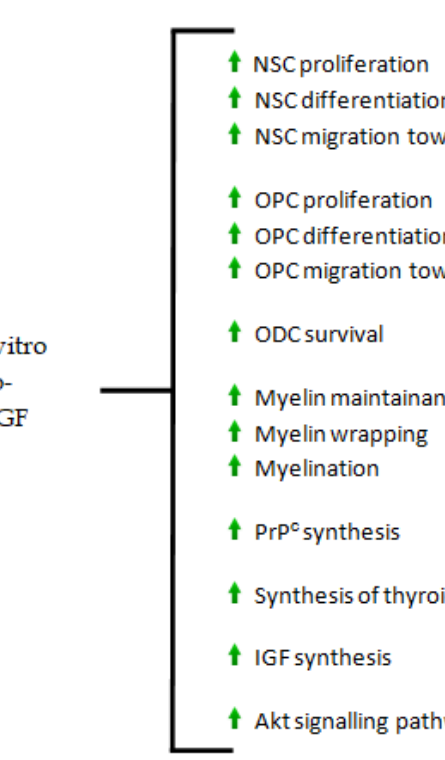
Figure 1. The main effects of epidermal growth factor (EGF) on oligodendrocytes (ODCs) and astrocytes (ASTs). The green arrows indicate stimulation. See text for details and references. IGF = insulin-like growth factor; NSC = neural stem cell; OPC = oligodendrocyte precursor cell; PrP C = normal cellular prion protein.